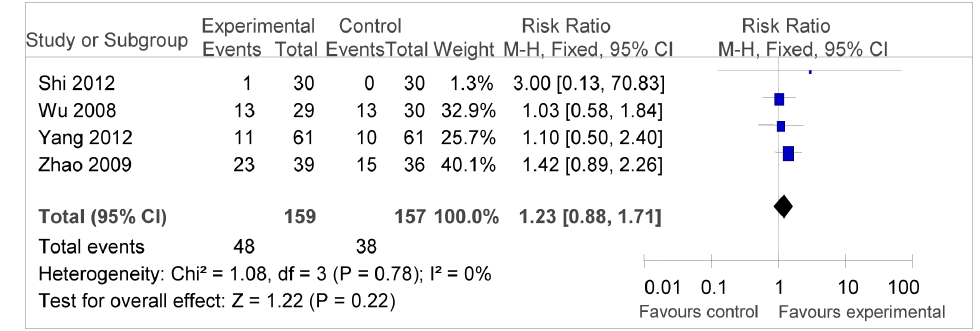
Figure 6. Forest plot of the comparison of partial response rate (PR). P values are from P for the effect modification evaluation of heterogeneity within or across the groups of regimens. CI, confidence interval; RR, risk ratio; DC/CIK, DC-CIK immunotherapy; Chemo, chemotherapy; Con, control group; Exp, experimental group. A fixed-effect meta-analysis model (Mantel-Haenszel method) was used.